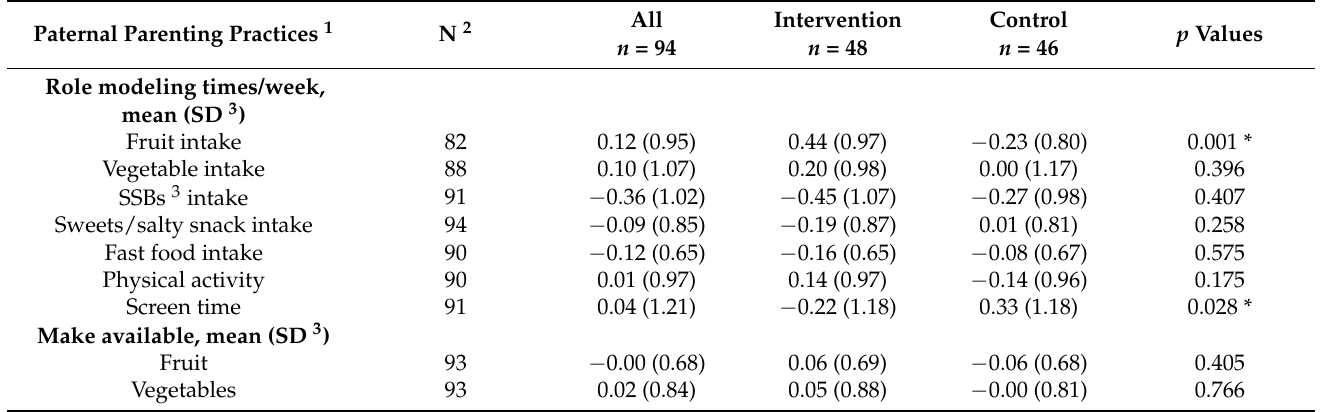
Table 3. Time-1 to Time-2 changes in paternal food and activity parenting practices